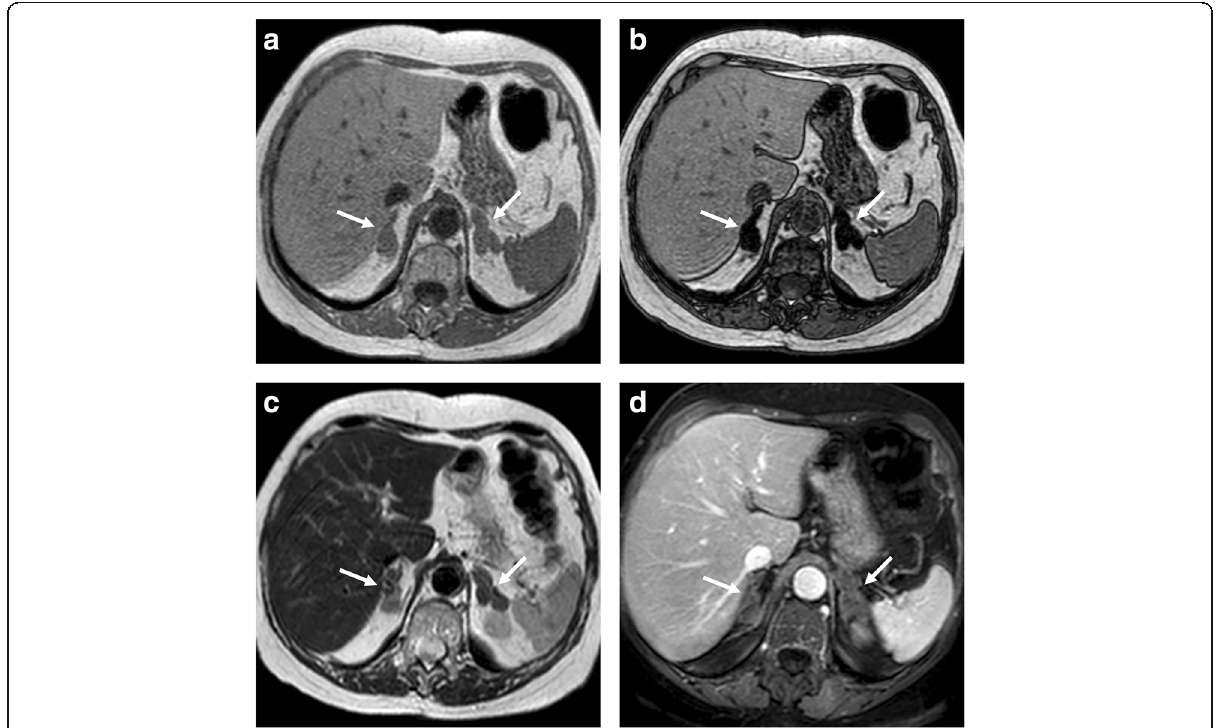
Fig. 2 Bilateral adrenal hyperplasia in a 75-year-old woman. Axial T1-weighted in-phase ( a ) and out-of-phase gradient recalled echo ( c ), T2- weighted fast spin echo ( c ), and three dimensional fat-suppressed T1-weighted gradient recalled echo image in portal phase after contrast injection ( d ) show the nodular enlargement of both adrenal glands (arrows) with loss of signal on out-of-phase ( b